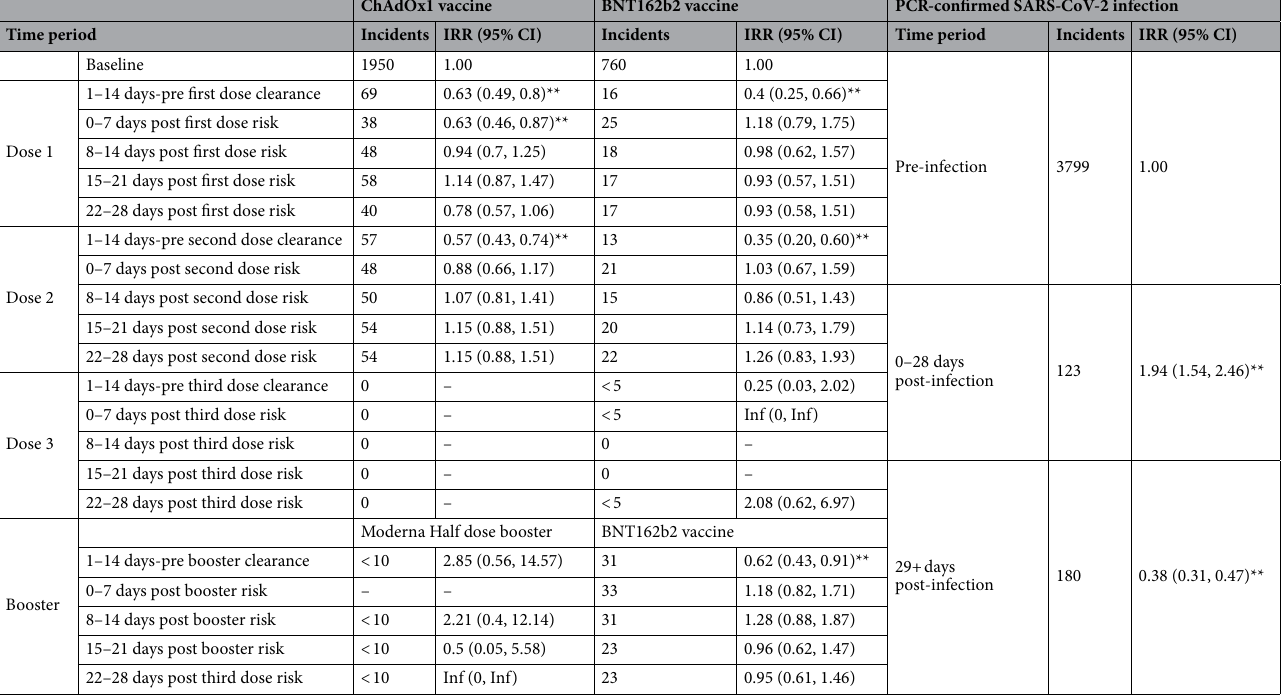
Table 2. Incidence rate ratios (95% confidence intervals) stratified by vaccination dose intervals, and separately by SARS-CoV-2 infection intervals (* P -value ≤ 0.05, ** P -value ≤